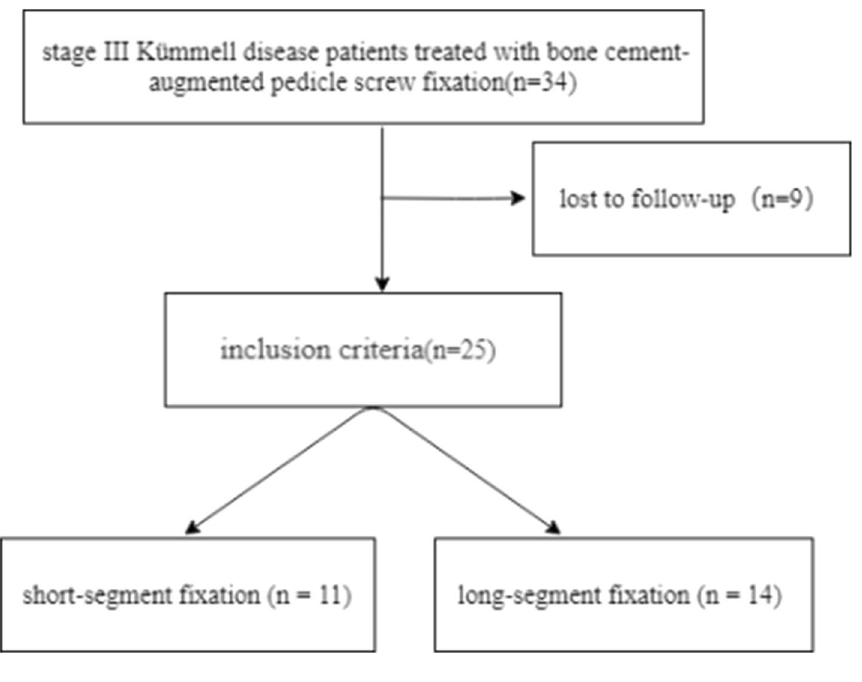
Figure 1. The research methodology flow